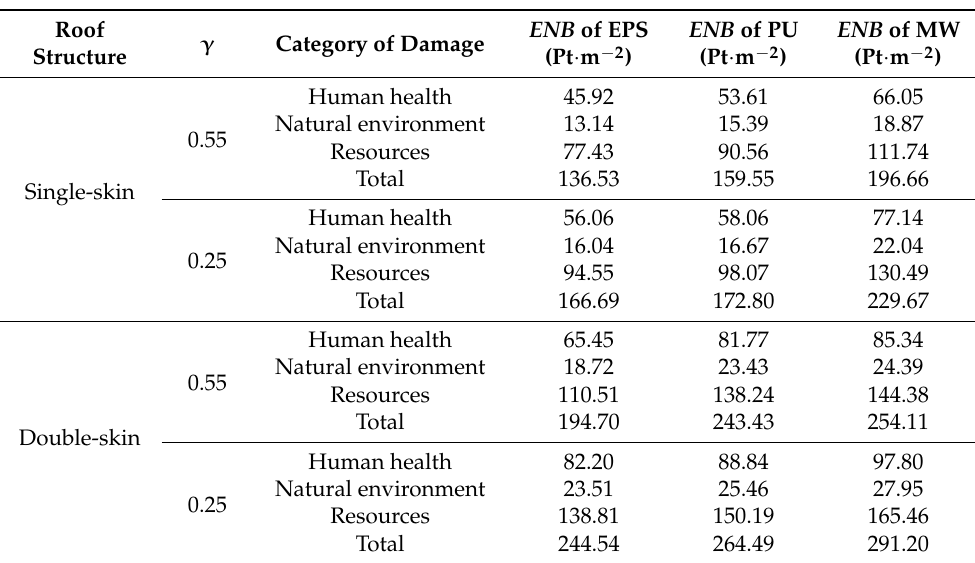
Table 6. Environmental benefits of roof thermal